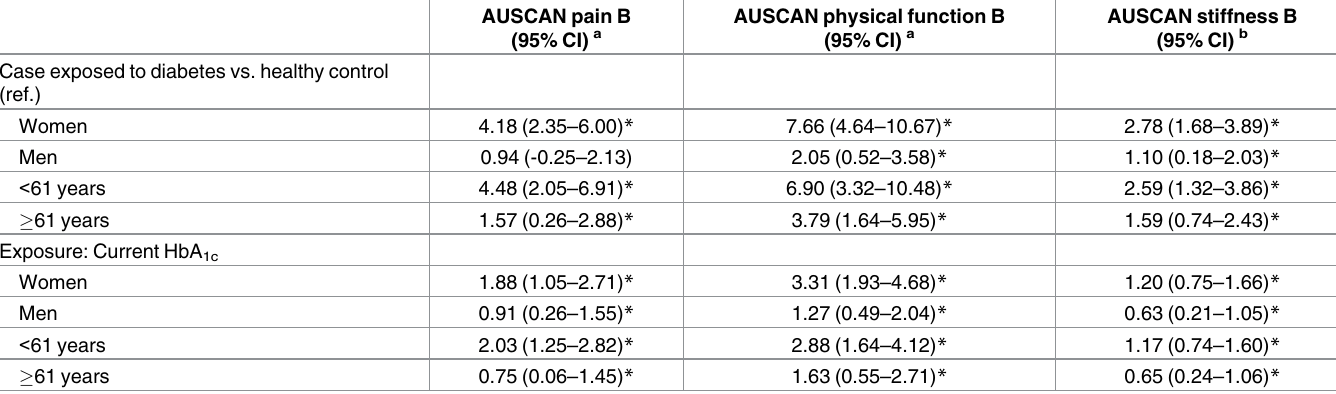
Table 4. Age and sex stratified analyses for the association between long term type 1 diabetes and hand pain, disability and hand stiffness.